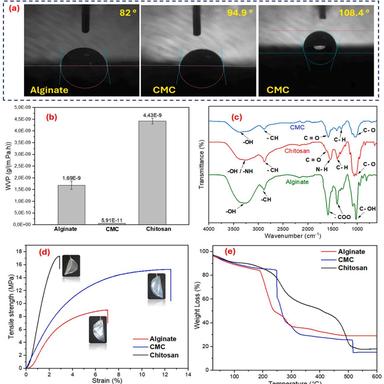
Biopolymer films characterization: (a) Water contact angle, (b) Water vapor permeability, (c) FT-IR spectroscopy, (d) Tensile strength and (e) Thermogravimetric analysis.